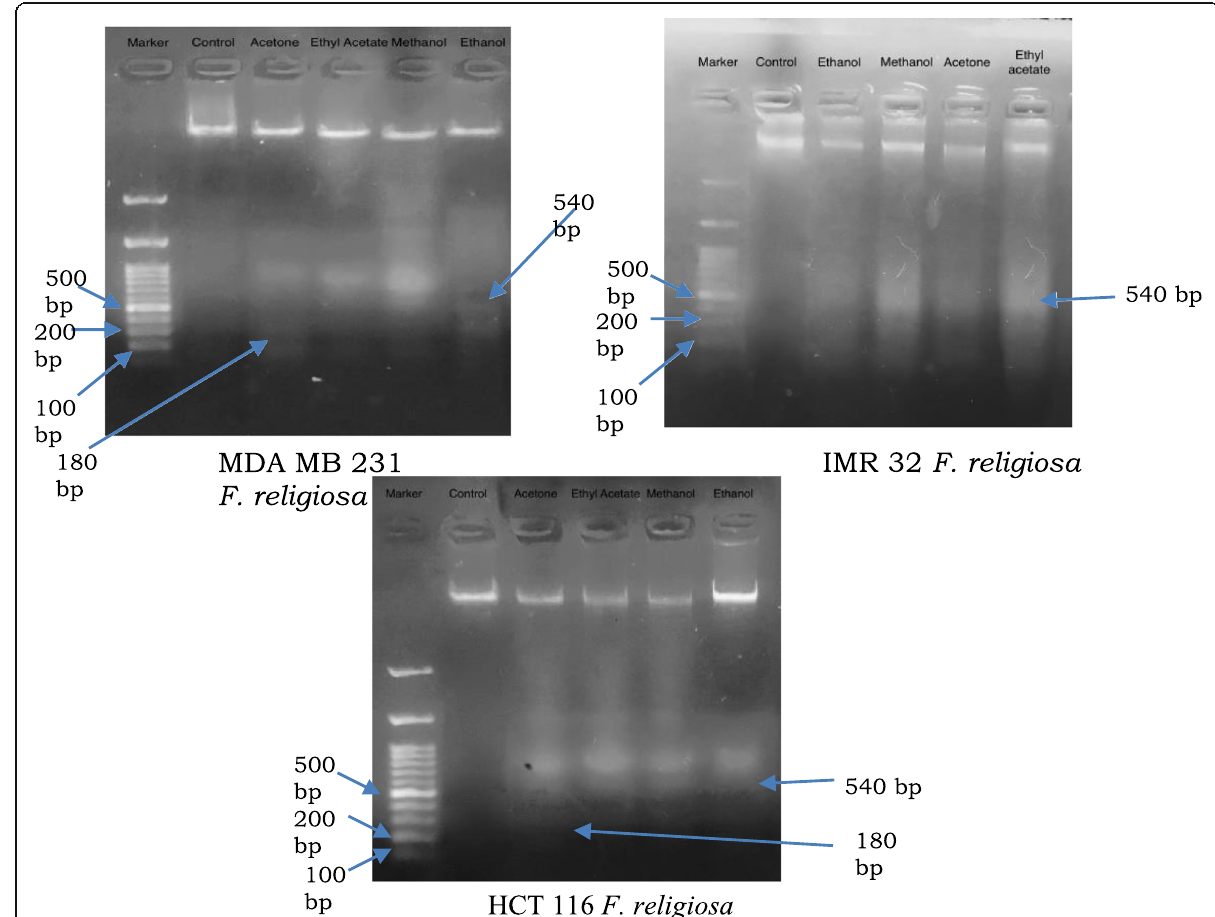
Fig. 9 DNA fragmentation in the form of DNA ladder was analyzed on 1.5 % agarose gel electrophoresis. A 100-bp marker is loaded in first well followed by control and treated cells by IC 50 concentrations of Ficus religiosa latex in MDA MB 231 methanol (145.5 μ g/ml), ethanol (50.86 μ g/ml), acetone (111.86 μ g/ml), and ethyl acetate (107.25 μ g/ml) extracts; IMR 32 methanol (146.01 μ g/ml), ethanol (4.8 μ g/ml), acetone (102.84 μ g/ml), and ethyl acetate (39.24 μ g/ml); HCT 116 methanol (122.89 μ g/ml), ethanol (24.27 μ g/ml), acetone (120.71 μ g/ml), and ethyl acetate (101.65 μ g/ml) extracts